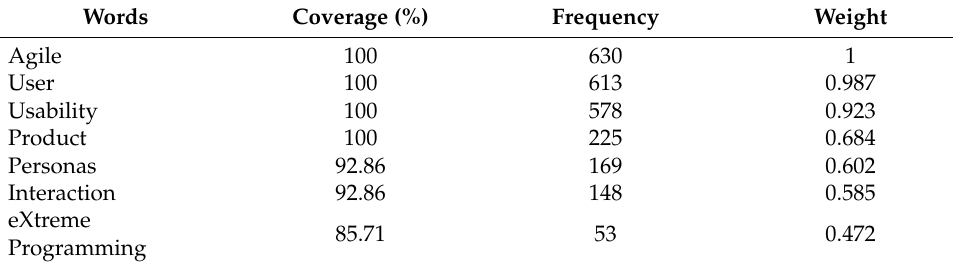
Table 1. Fragment of the list of words obtained from the selection process.